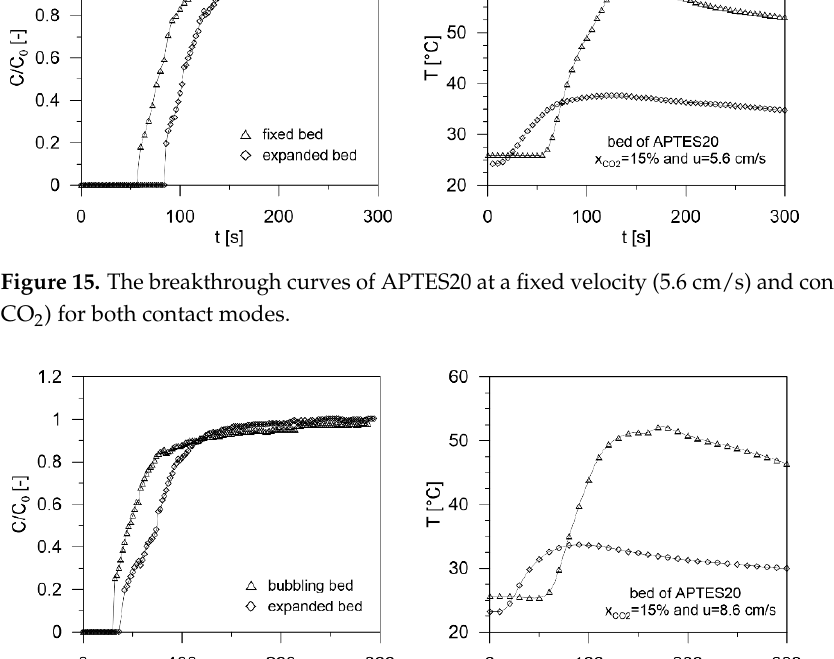
Figure 16. The breakthrough curves of APTES20 at a fixed velocity (8.6 cm/s) and concentration (15% CO 2 ) for both contact modes.